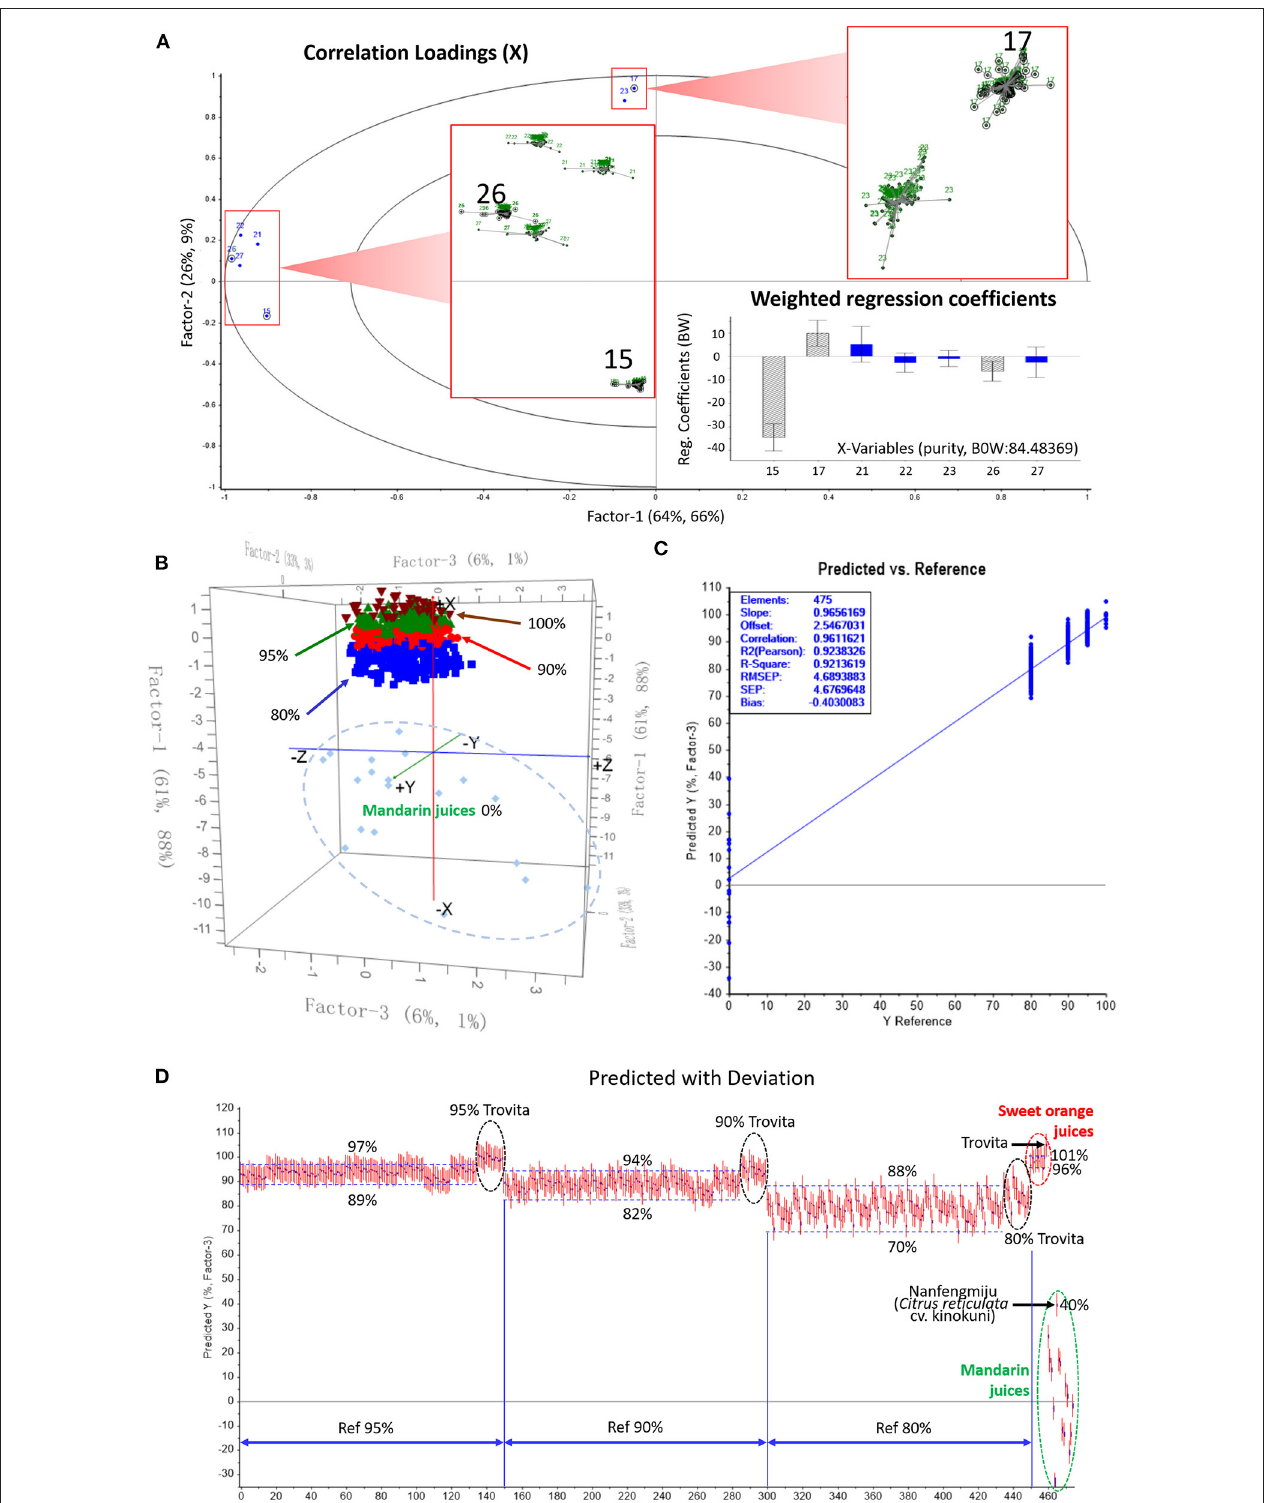
FIGURE 4 | Partial least squares discriminant analysis (PLS-DA) of sweet orange juice incorporated with different proportion of mandarin juice. (A) Methoxyflavone variables reduction according to the uncertainty and regression coefficients; (B) Score plot of training set showing clustering of different mixtures of sweet orange and mandarin juice; (C) Prediction ability of the PLS regression model evaluated by external validation; (D) Prediction results of orange juice purity in mixed juices.